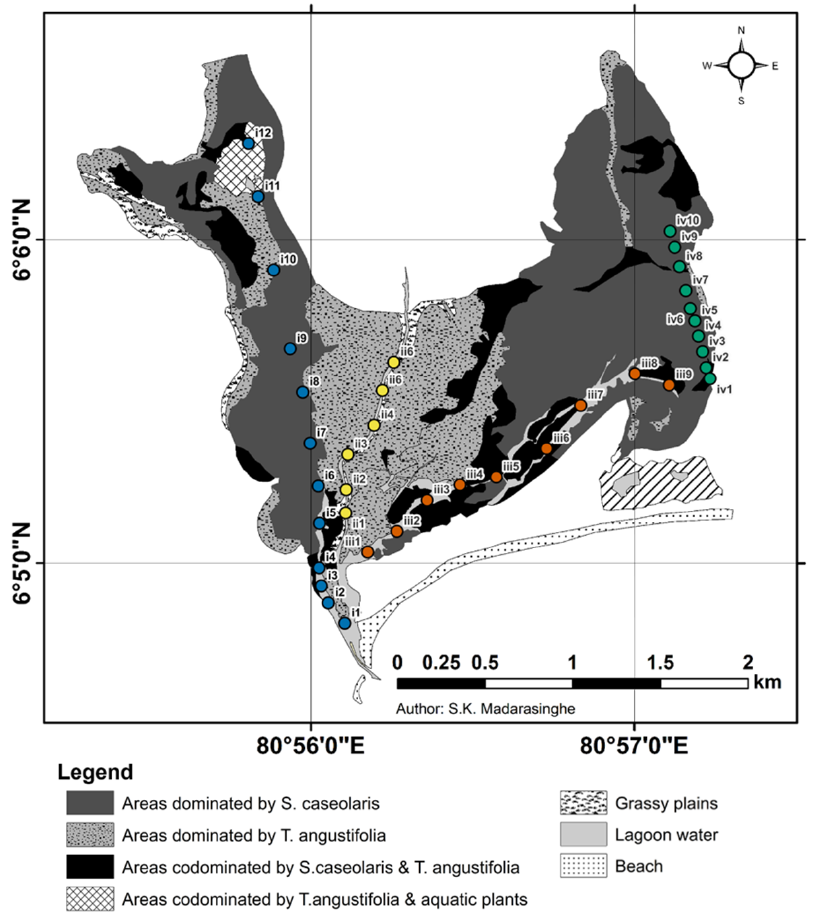
Figure 2. Land-Use Map of Kalametiya Lagoon (© S. K. Madarasinghe) with the 37 point-count station sites. Seven considered habitat types are described in the legend, along with their respective patterns: (i) areas dominated by S. caseolaris (dark grey), (ii) areas dominated by T. angustifolia (grey with black spots), (iii) areas co-dominated by S. caseolaris and T. angustifolia (black), (iv) areas co-dominated by T. angustifolia and aquatic plants (white with two layers of black stripes), (v) grassy plains (white with grass symbols), (vi) lagoon water (light grey), (vii) beach (white with black spots).Sites are displayed in four different colours: blue for Transect I, yellow for Transect II, red for Transect III, green for Transect IV. Sites labels show their respective transect (i = Transect I, ii = Transect II, iii = Transect III, iv = Transect IV) and numbers. The area coordinates are present on the left and bottom sides of the map. A scale in kilometres is presented under the map.